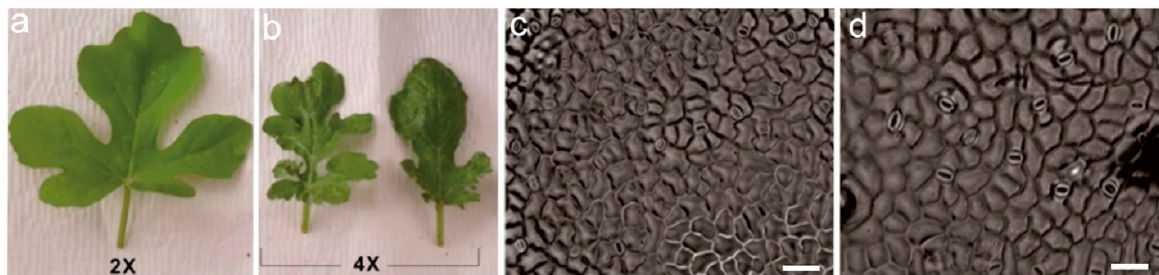
Figure 5. Leaf morphology and stomata size of watermelon induced by oryzalin. ( a ). diploid leaf, ( b ). tetraploid leaf, ( c ). stomata of diploid, and ( d ). stomata of a tetraploid leaf, respectively. Scale bar= 10 µm [17].